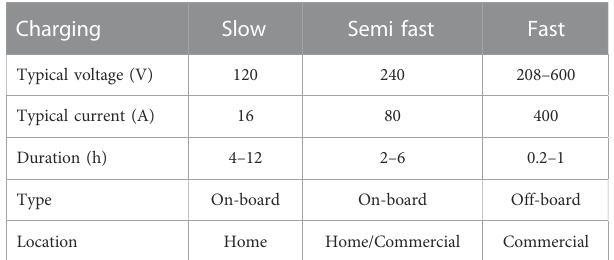
TABLE 6 Various charging levels for electric